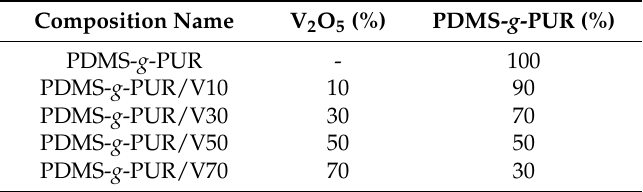
Table 1. Composition of PDMS- g -PUR/V 2 O 5 composites.